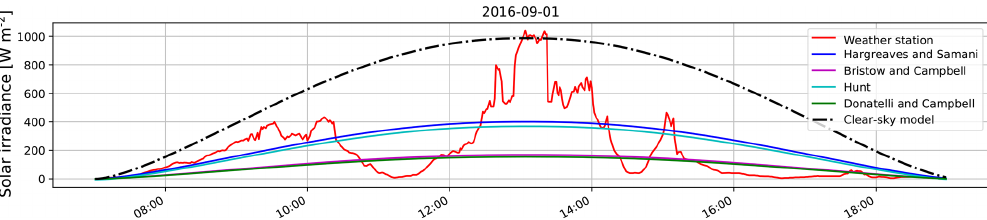
Figure 10. Comparison amongst different benchmarking solar estimation models, along with the clear-sky model and measured solar irradi- ance on 1 September 2016. Most of the existing algorithms fail to capture the rapid fluctuations of the measured solar irradiance.